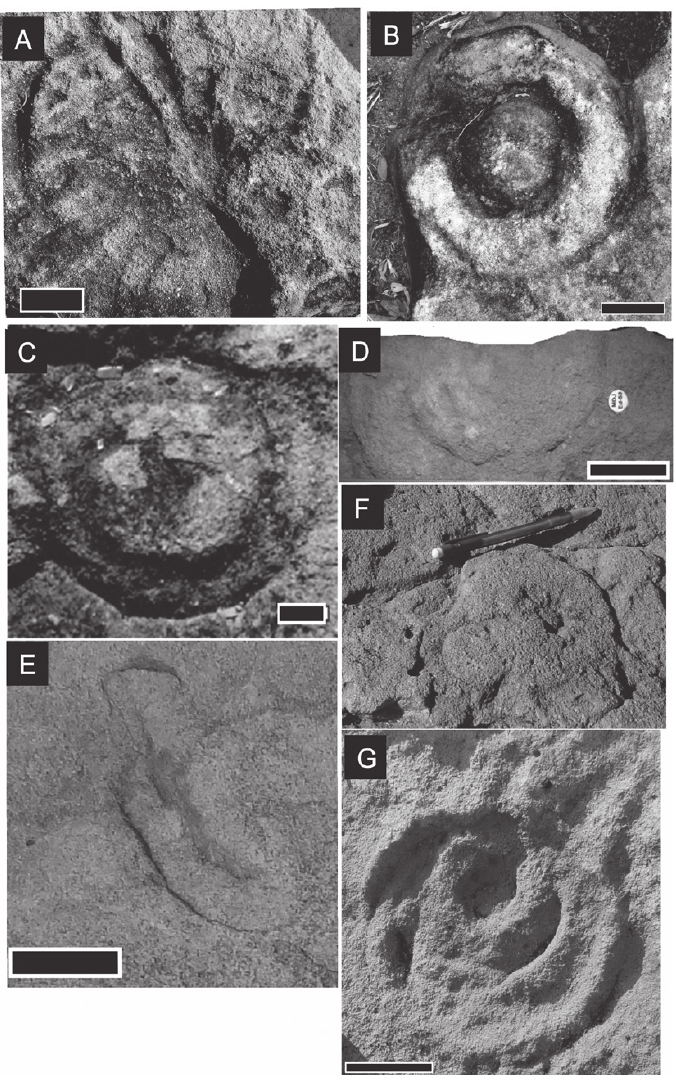
Figure 4 - Ediacaran fauna. A , Charniodiscus arboreus (Scale 3 cm); B , Charniodiscus concentricus (Scale 4 cm); C , Cyclomedusa davidi (Scale 1 cm); D , Ediacaria flindersi (Scale 5 cm); E , Kimberella quadrata (Scale 2 cm); F , Medusinites asteroides (Scale 15 cm); G , Palaeophragmodictya reticulata (Scale 5